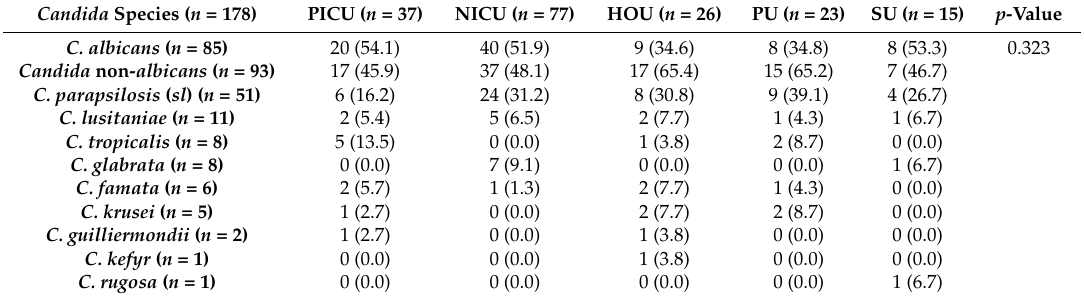
Table 2. Distribution of Candida species by units during the study period (2008–2017).